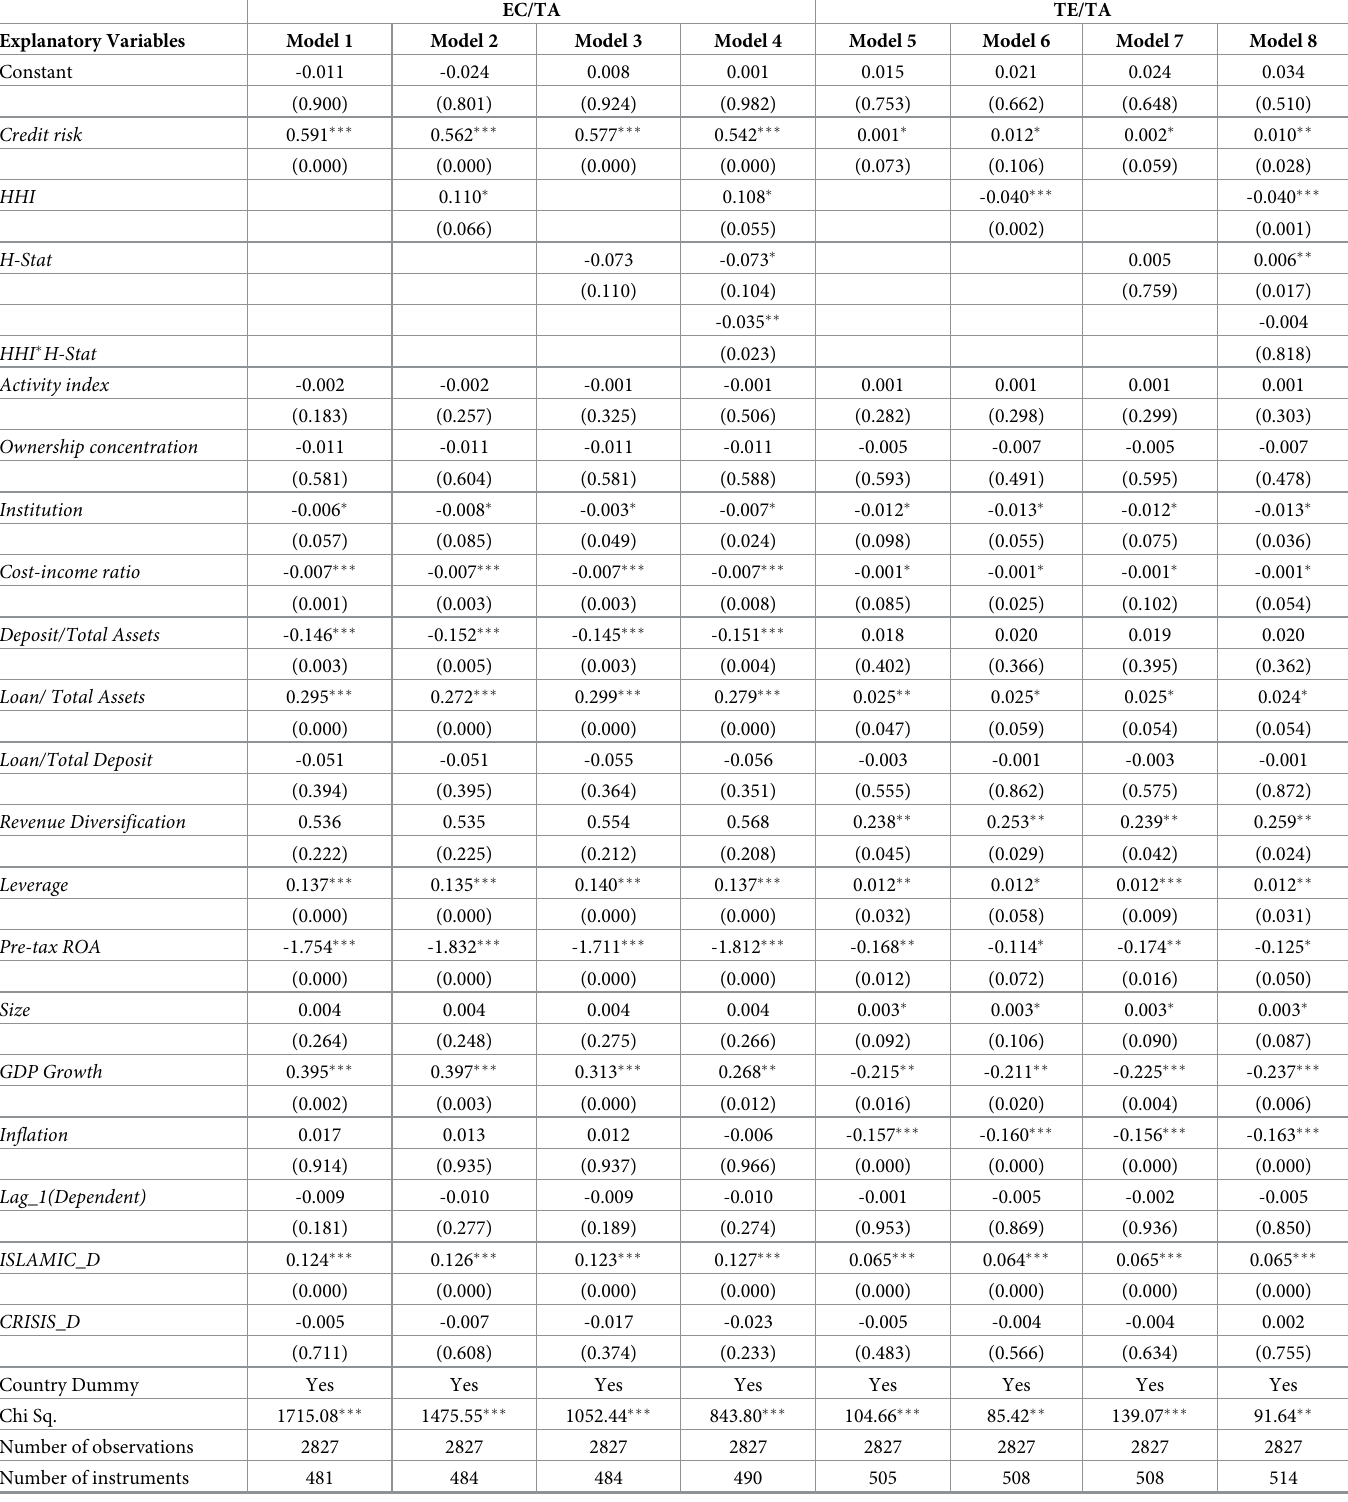
Table 9. Panel regressions (GMM) of competition and capital ratio (all banks,